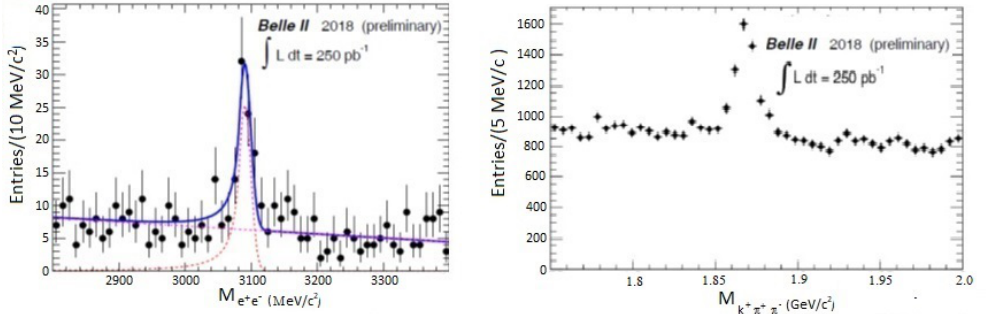
Figure 4. Invariant mass plot for J / ψ ( left ) and D + ( right )